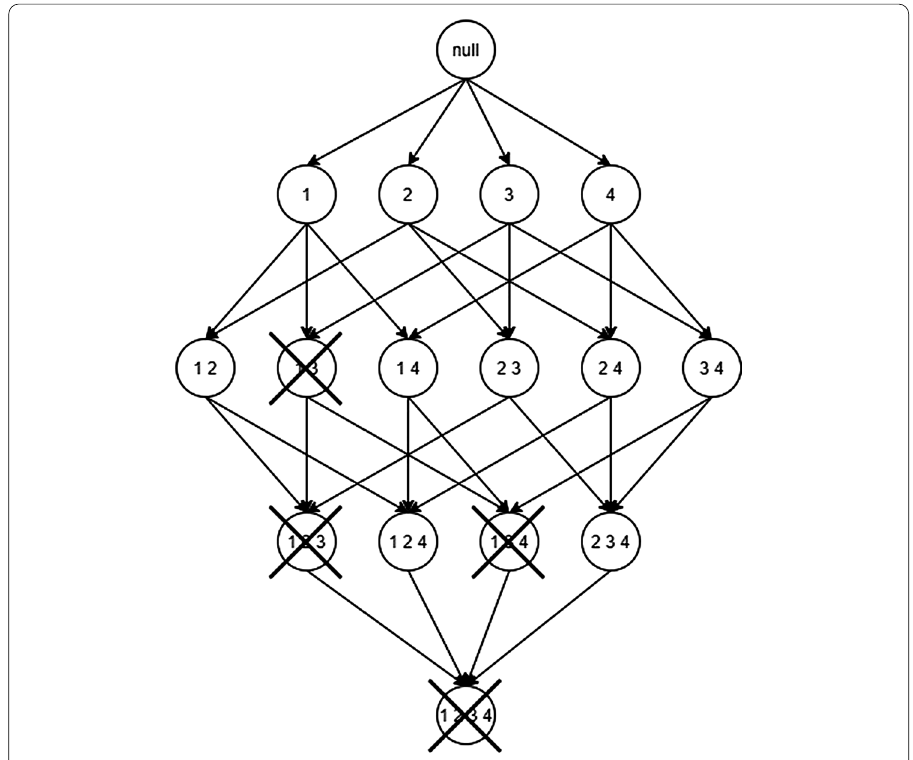
Fig. 5 An example of